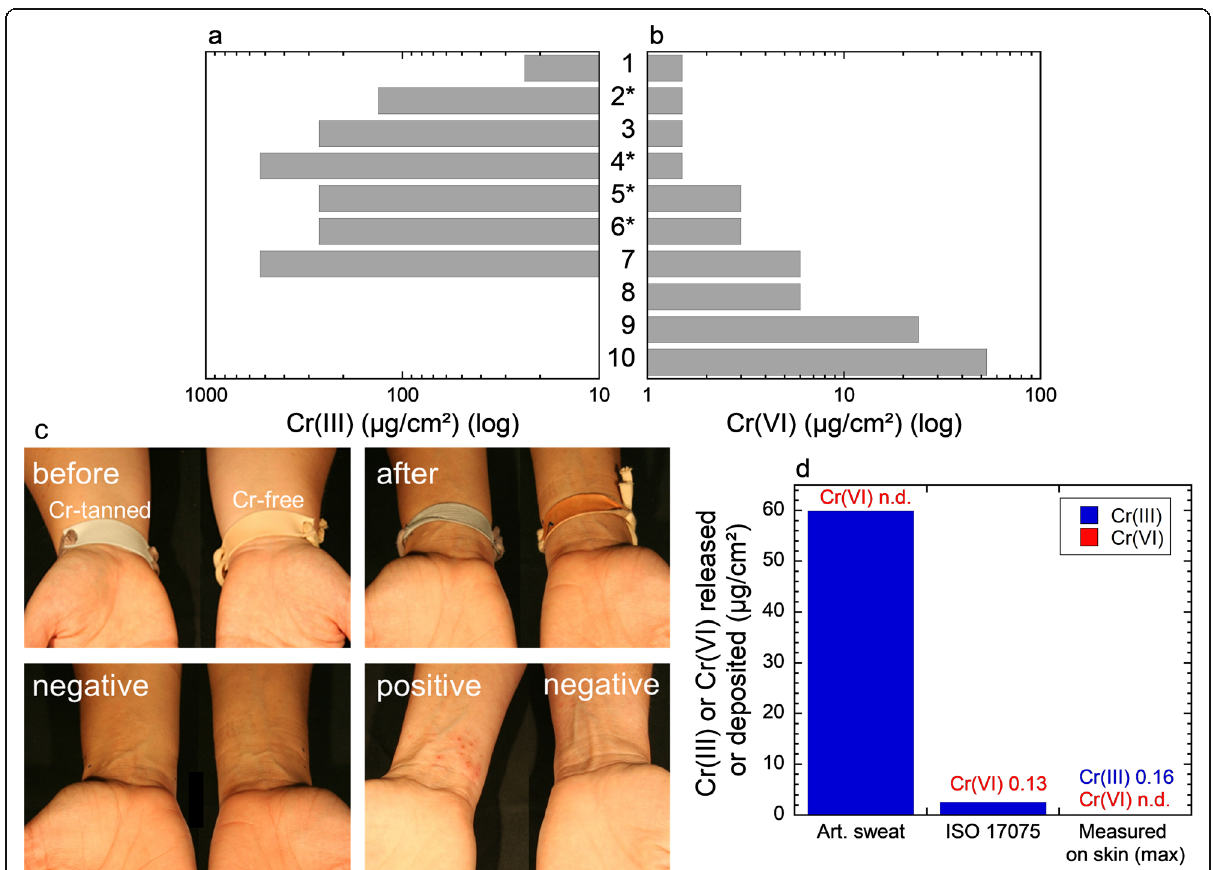
Fig. 3 The minimum elicitation threshold (the lowest skin dose that the person reacted positively to) for trivalent chromium ( a ) and hexavalent chromium ( b ) of ten chromium-allergic individuals in [36]. The asterisks mark the individuals that reacted positively to a chromium-tanned leather bracelet (the grey bracelet shown in c ) within 3 weeks of usage. The appearance of the leather bracelets (chromium-tanned and control bracelet) before and after the 3 weeks use test, and examples of positive and negative allergic skin reactions to the leather bracelets are shown in ( c ). Trivalent and hexavalent chromium released from the chromium-tanned leather used for the bracelet into artificial sweat and during an ISO 17075 test (phosphate buffer), and the measured maximum amount deposited on the skin of the participants after 3 weeks of bracelet usage ( d ). Cr – chromium; Cr(VI) – hexavalent chromium; Cr(III) – trivalent chromium; art. sweat – artificial sweat; n.d. – not